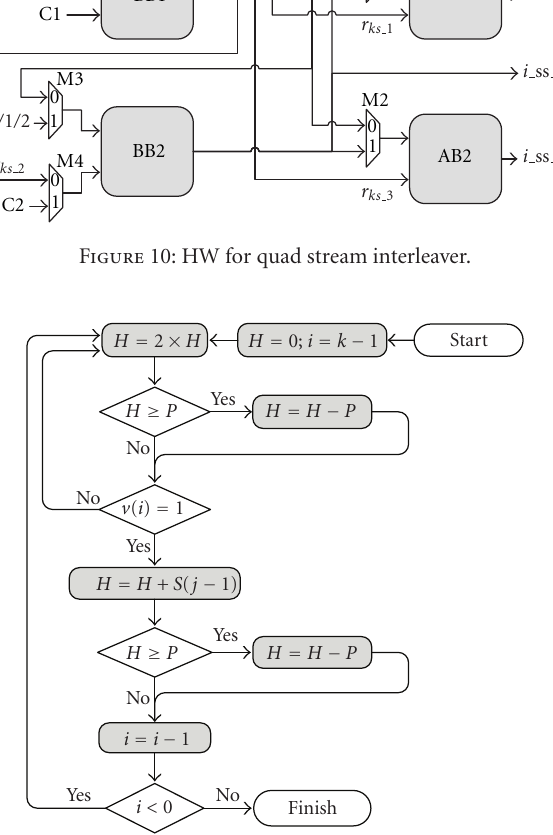
Figure 11: Flow graph for interleaved modulo multiplication